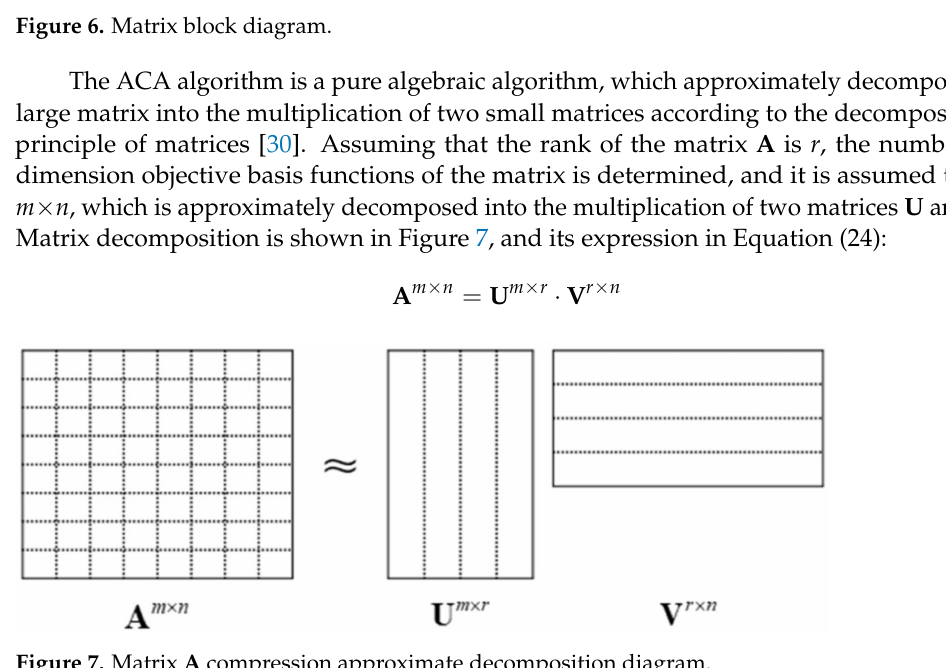
Figure 7. Matrix A compression approximate decomposition